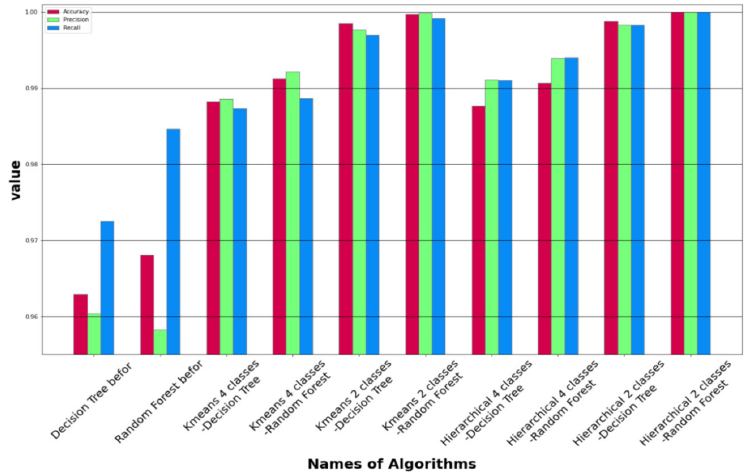
Fig. 15. The accuracy comparison in the first and second phases before the feature selection